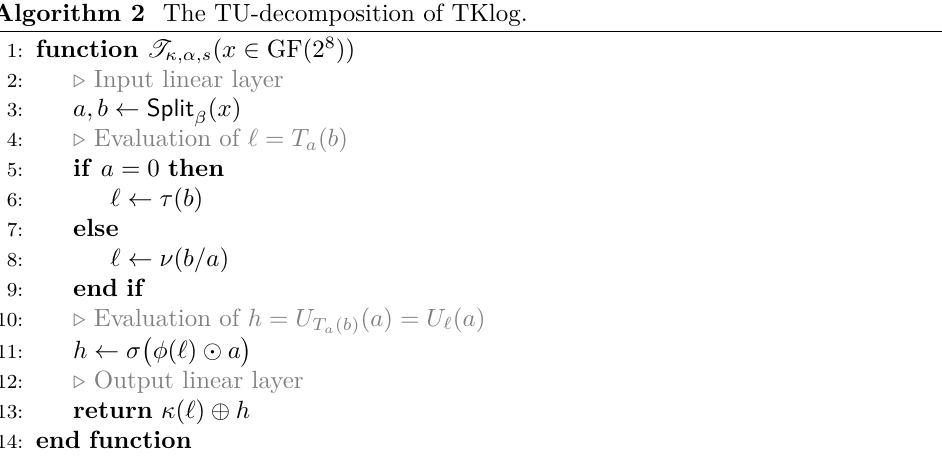
Algorithm 2 The TU-decomposition of